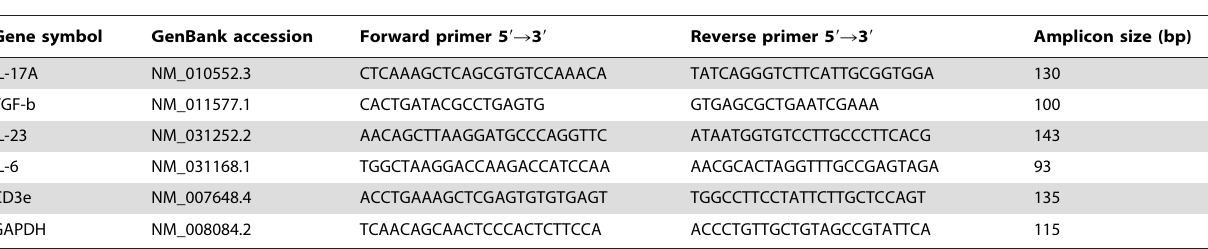
Table 1. Mouse primer sequences.